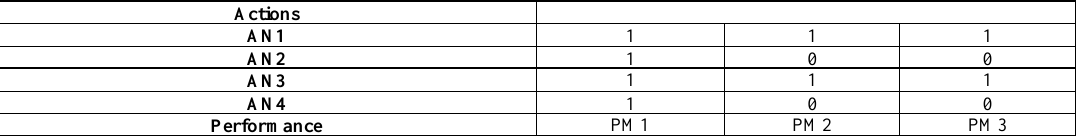
Table 12. Cross interaction binary matrix for action and performance.